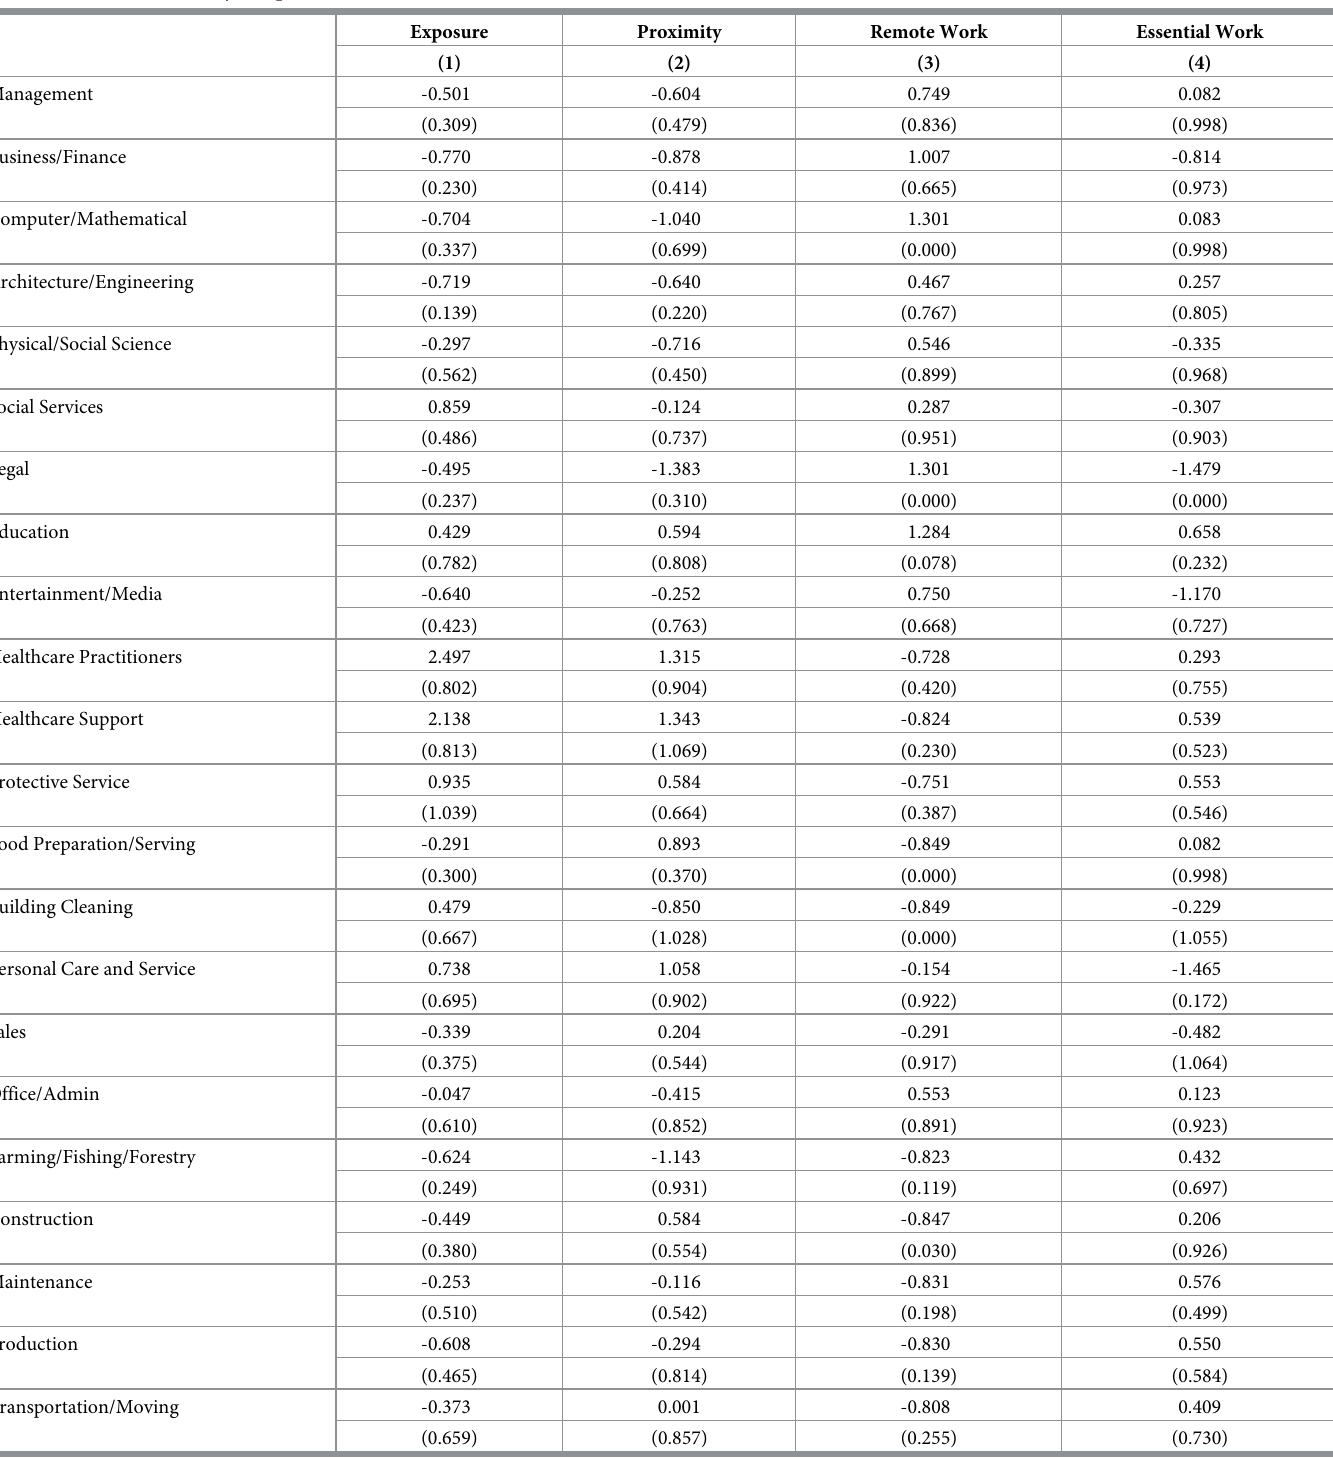
Table 4. Mean index values by occupations.